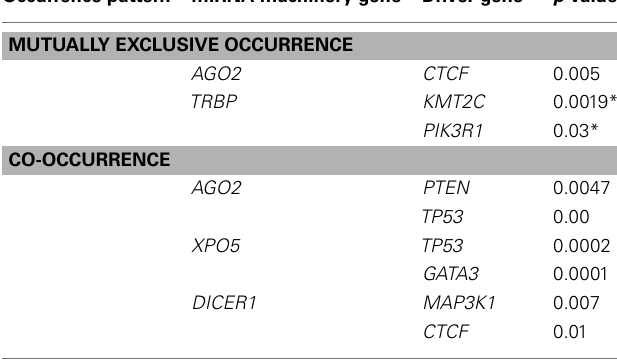
Table 2 | Patterns of mutual exclusivity and co-occurrence of driver genes and microRNA machinery gene alteration inThe Cancer GenomeAtlas consortium data for the breast invasive carcinoma dataset ( N = 463)